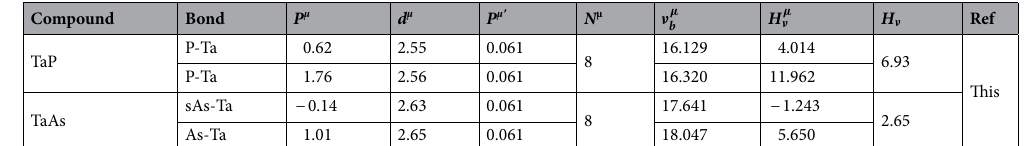
Table 11. The calculated Mulliken bond overlap population of µ -type bond P µ , bond length d µ (Å), metallic population P µ ′ , total number of bond N µ , bond volume ν Vickers hardness of the compound, H ν (GPa) of TaP and